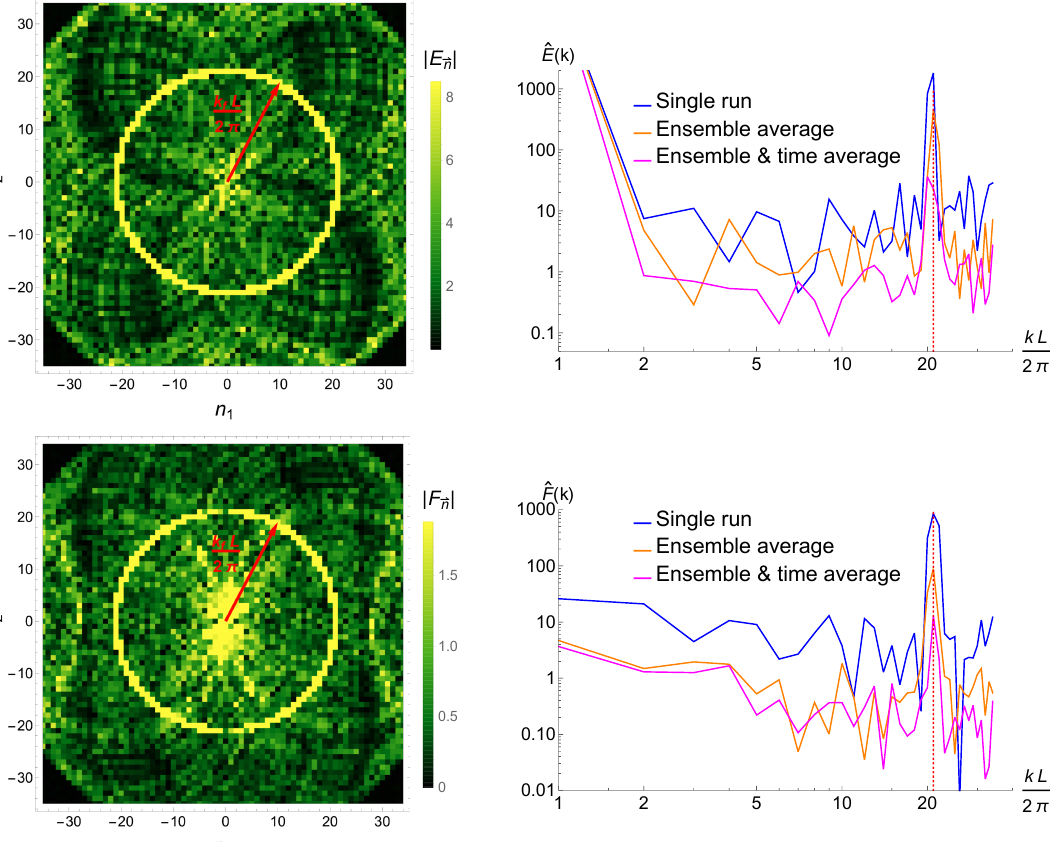
Figure 2 . A set of plots exhibiting the behavior of the Fourier decomposition of the energy P density (top) and energy flux (bottom), 16 πG N T 00 ( t, ~x ) = 1 E ~n e i 2 π~n L · ~x (top right, not to ~n 3 ‘ 2 L 2 ρ 0 be confused with the power spectrum of the non relativistic kinetic energy defined in (5.4)) and P 16 πG N T 01 ( t, ~x ) = 1 F ~n e i 2 π~n L · ~x , at t = 1125 ρ 0 with ρ 0 = 4 πT 0 / 3 and T 0 the initial temperature. ~n 3 ‘ 2 L 2 ρ 0 Plots of | E ~n | and | F ~n | appear on the left column. The centered ring is located at the driving scale, k f . In the right column we have plotted the (dimensionless) angle averaged energy density ˆ E ( | ~k | ) = R E | ~k | L | ~k | L dθ and flux ˆ F ( | ~k | ) = R F dθ (where E ~n and F ~n have been analytically ~kL ~kL 2 π 2 π 2 π 2 π continued to all values of ~n ) for a single run (blue), an average over 36 independent runs (orange) and a further average over 19 nearby time steps (pink). The dashed red line corresponds to the driving scale k f